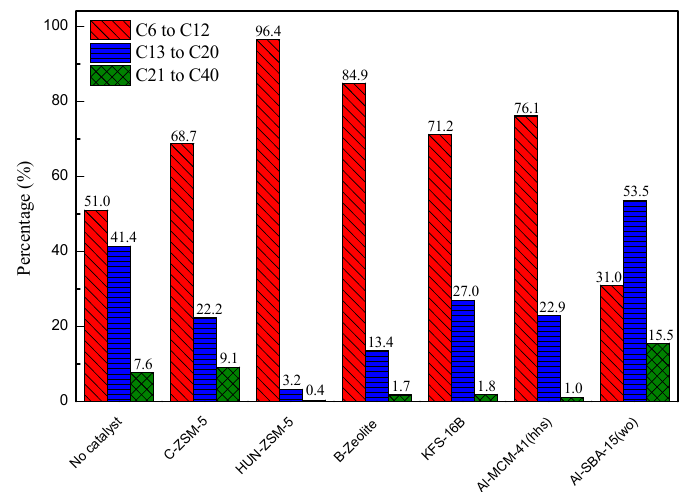
Figure 6. Distribution of the liquid and wax products in terms of carbon number. Table 3. Main constituents of the pyrolysis oil and wax products determined by gas chromatography ‐ mass spectrometry (GC ‐ MS) (%area).